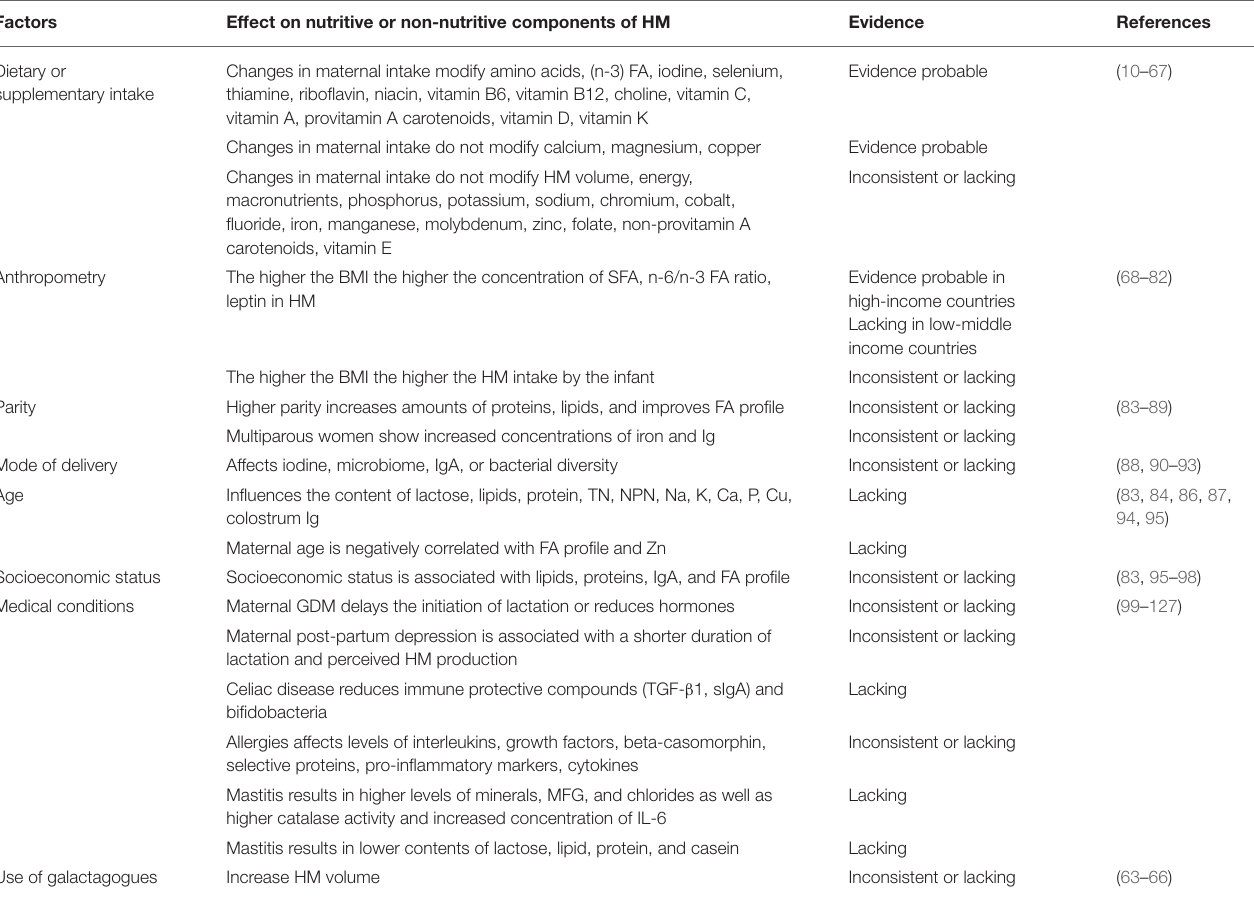
TABLE 1 | Maternal factors affecting nutritive and non-nutritive components of human